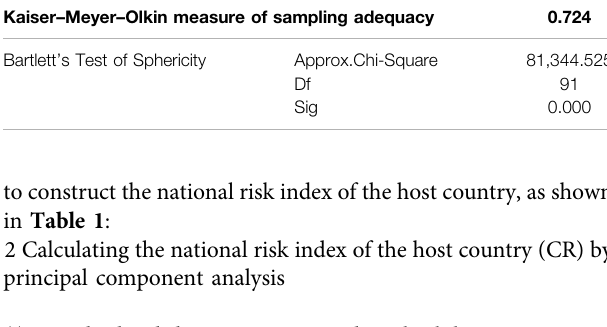
TABLE 2 | KMO and Bartlett ’ s test results.